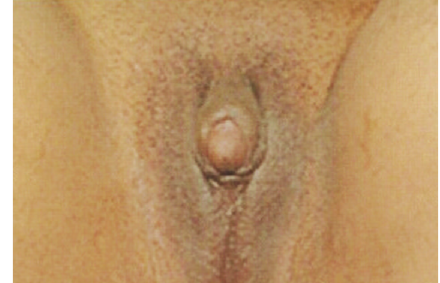
Figure 1: Clitoromegaly and ambiguous genitalia.